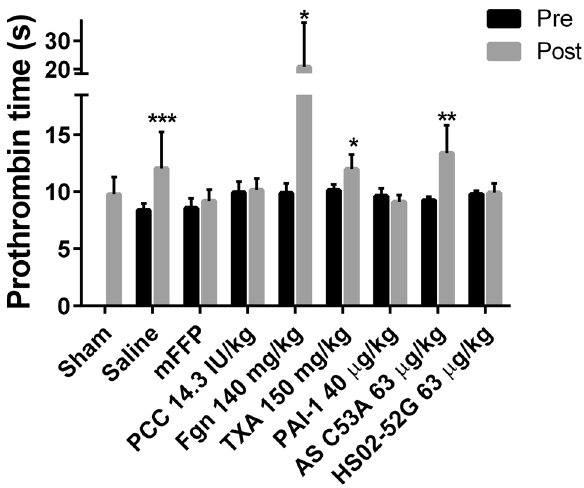
Figure 4. Clotting times pre- and post-treatment. Prothrombin time (PT) values (s) are shown for mice whose blood loss values are shown in Fig. 3. Pre (black bars), from plasma of blood sampled prior to haemorrhagic shock (HS) and resuscitation with fluids and doses shown on x axes and liver laceration (LL); Post (grey bars), from plasma of blood sampled after HS/LL and resuscitation. Values are the mean of 6 determinations ± SD in all cases except n = 8 for saline. Asterisks above “Post” bars indicate statistically significant differences from “Pre” values by Mann–Whitney U tests (* p < 0.05, ** p < 0.01, *** p <